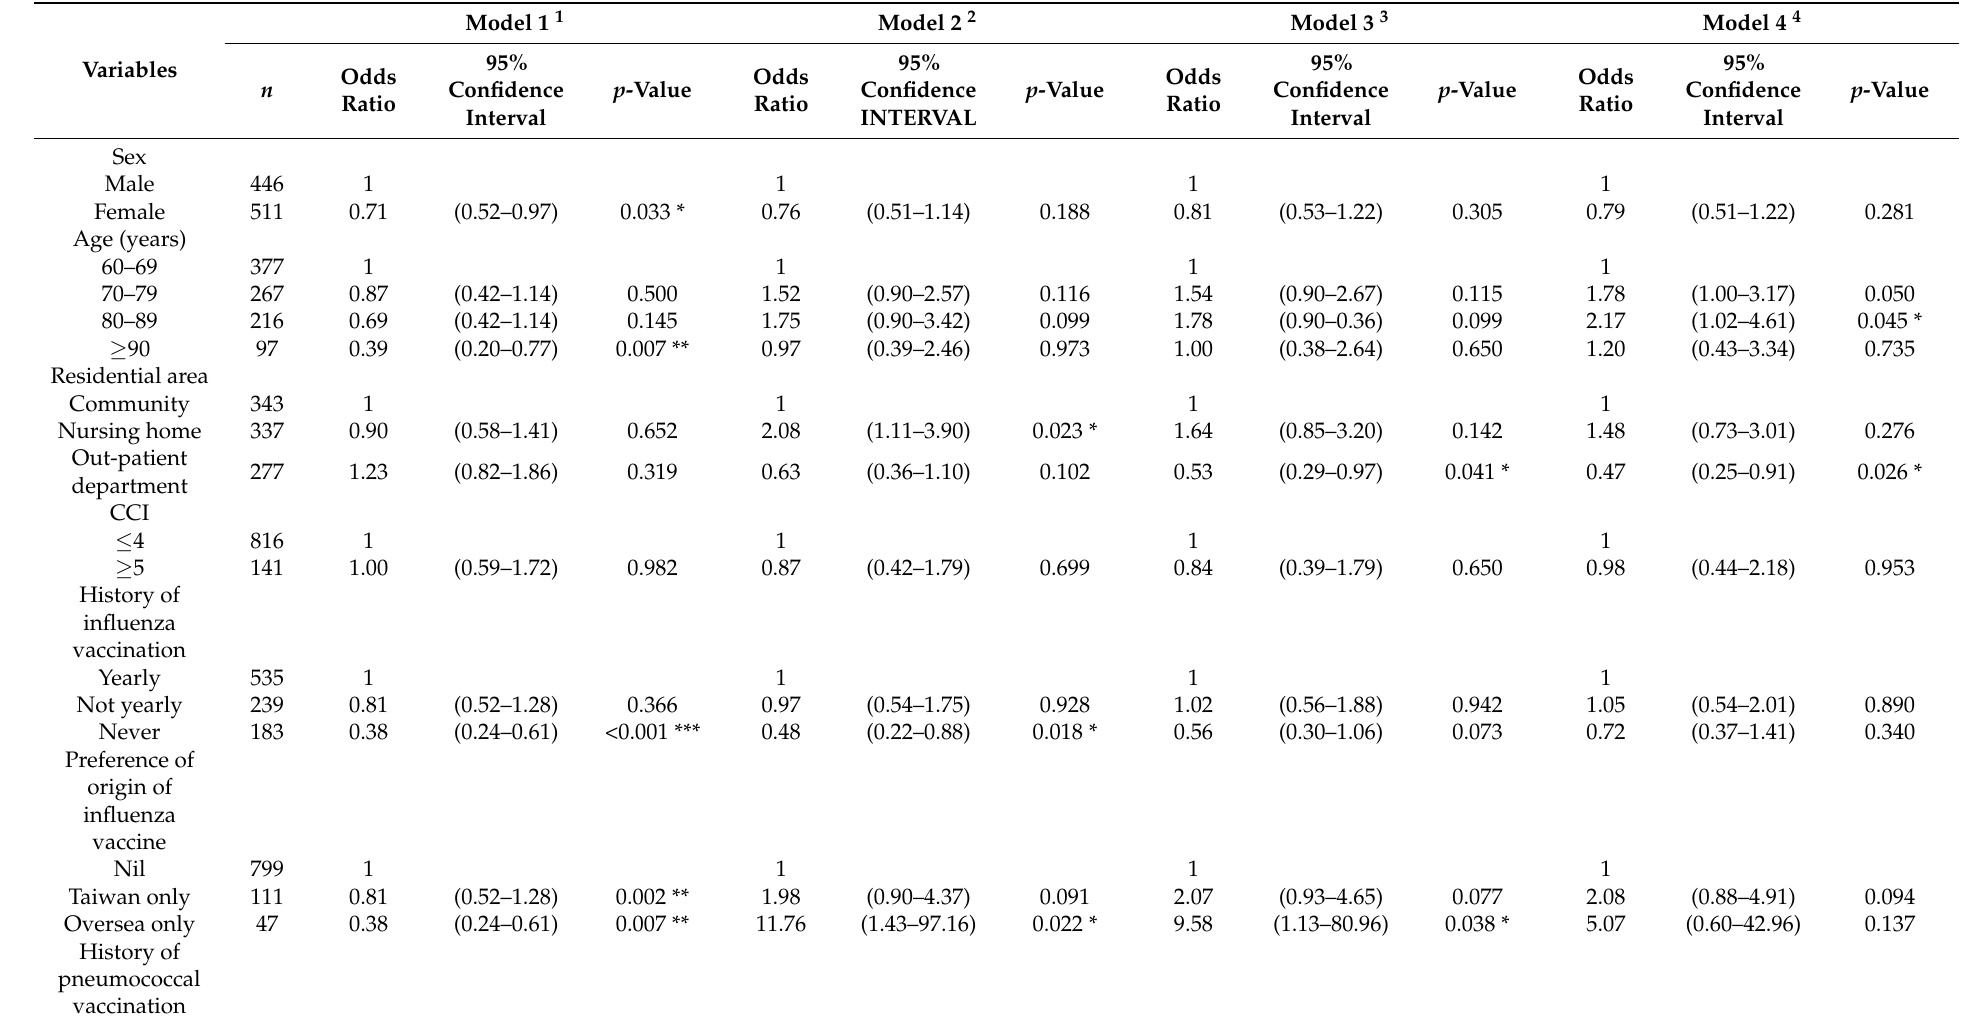
Table 5. Individual variables associated with positive willingness to accept the COVID-19